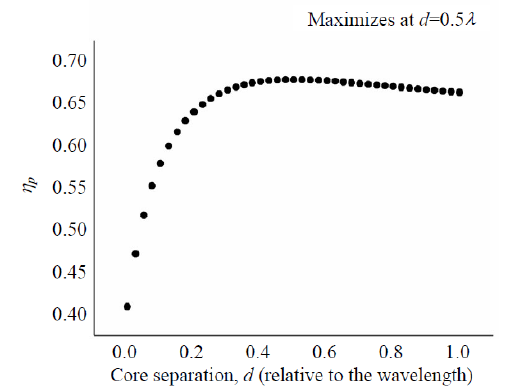
Fig. 6 Values of the parameter  separation d in the case of